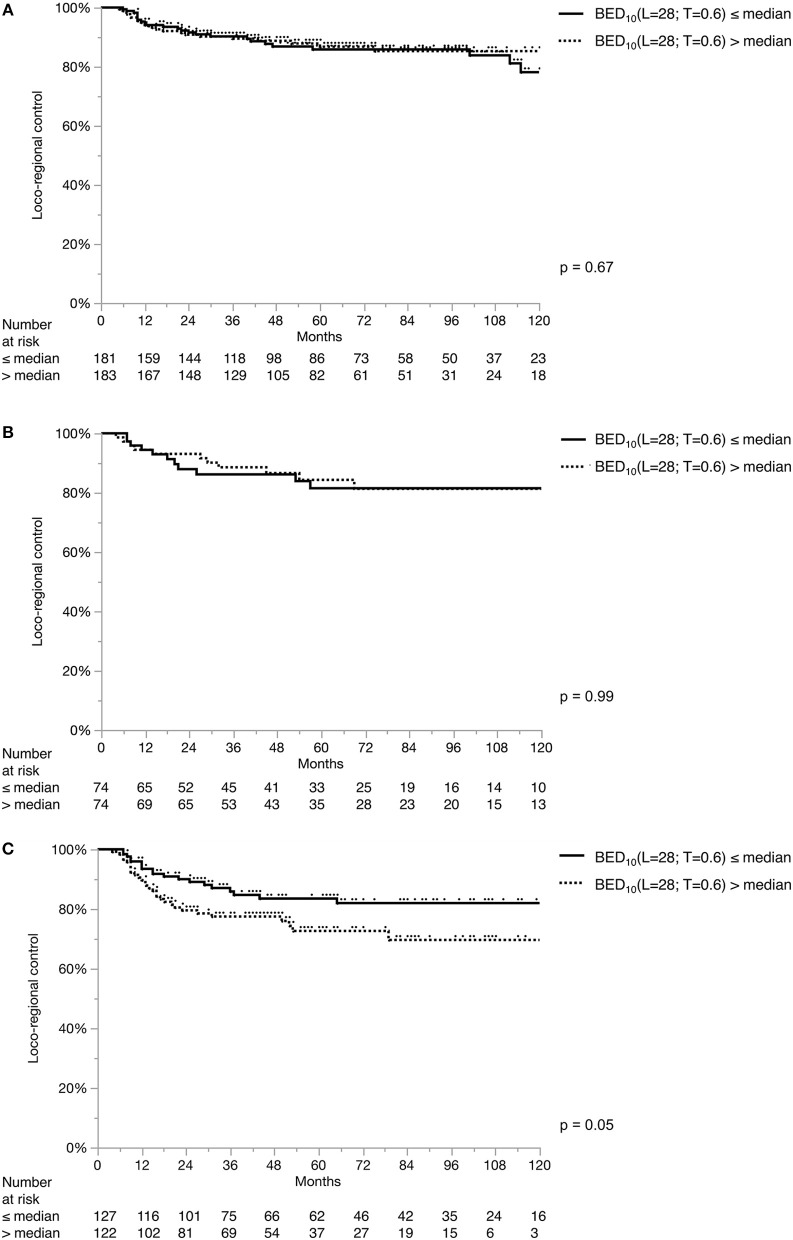
Loco-regional control separated by median BED10(L = 28; T = 0.6). Loco-regional control in T1a (A), T1b (B), and T2 (C) tumors. Each stage subgroup is dichotomized with its own median value: stage T1a: 70.6 Gy; stage T1b: 70.8 Gy; stage T2: 71.93 Gy.